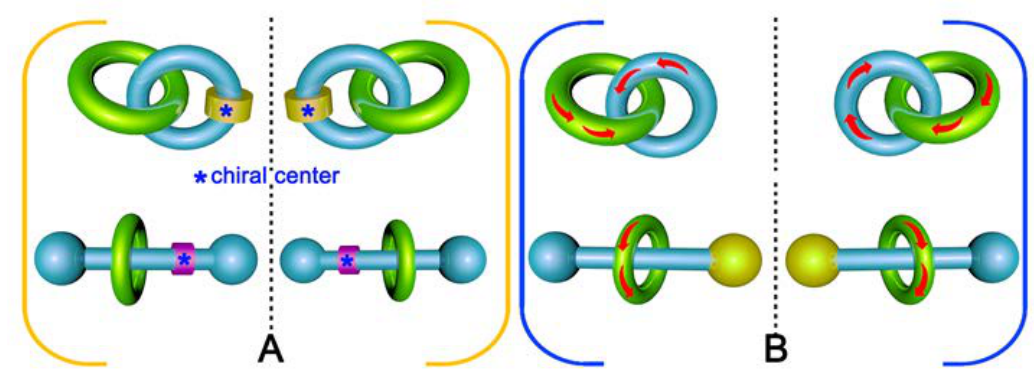
Figure 1. Chiral catenanes and rotaxanes. Chirality arising from ( A ) classical chiral elements and ( B ) “mechanical chirality” with achiral “directional” elements.